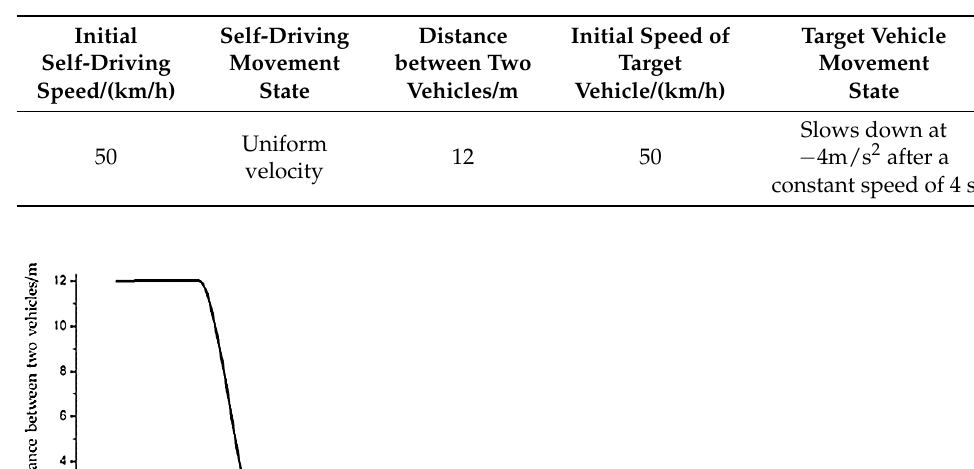
Table 7. CCRb test conditions.